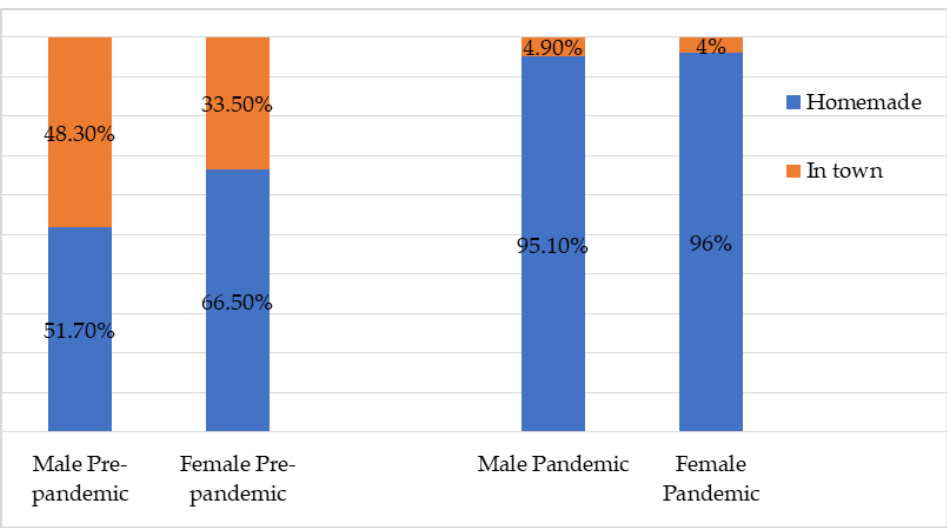
Figure 1. Where did you eat the main meal.